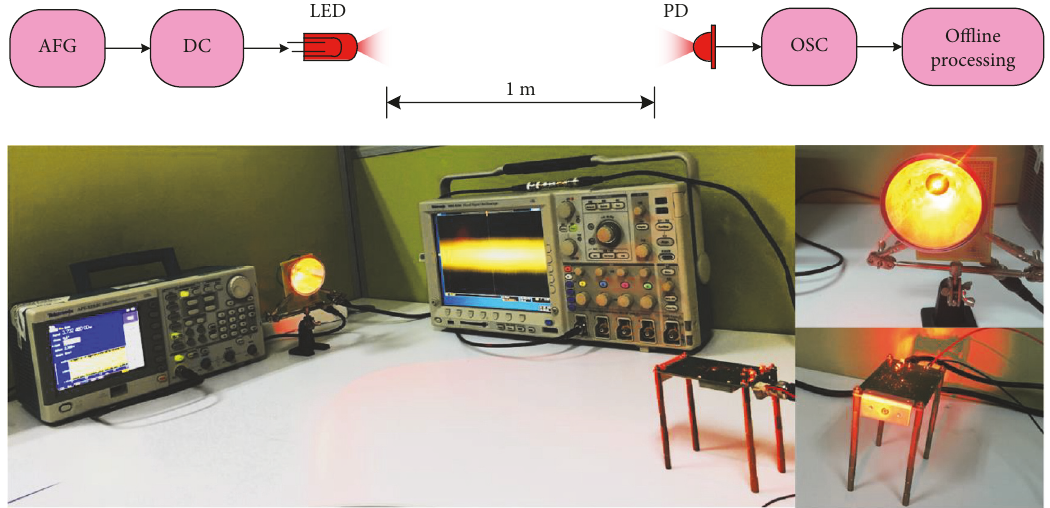
Figure 3: Experimental setup of the OFDM VLC system with ZCM precoding.